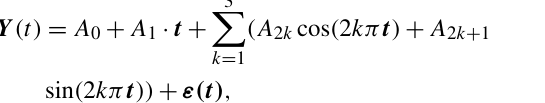
Figure 5. N 2 O profiles from the NDACC a priori profile (NDACC ap), TCCON a priori profile (TCCON ap), NDACC retrievals inside and outside the polar vortex (NDACC-I/NDACC-O), co-located ACE-FTS measurements inside (three days) and outside (40 days) the polar vortex (ACE-I/ACE-O), and the ACE-FTS measurements smoothed with the NDACC AVK inside and outside the polar vor- tex (ACE-I sm/ACE-O sm). The error bar is the standard deviation of each